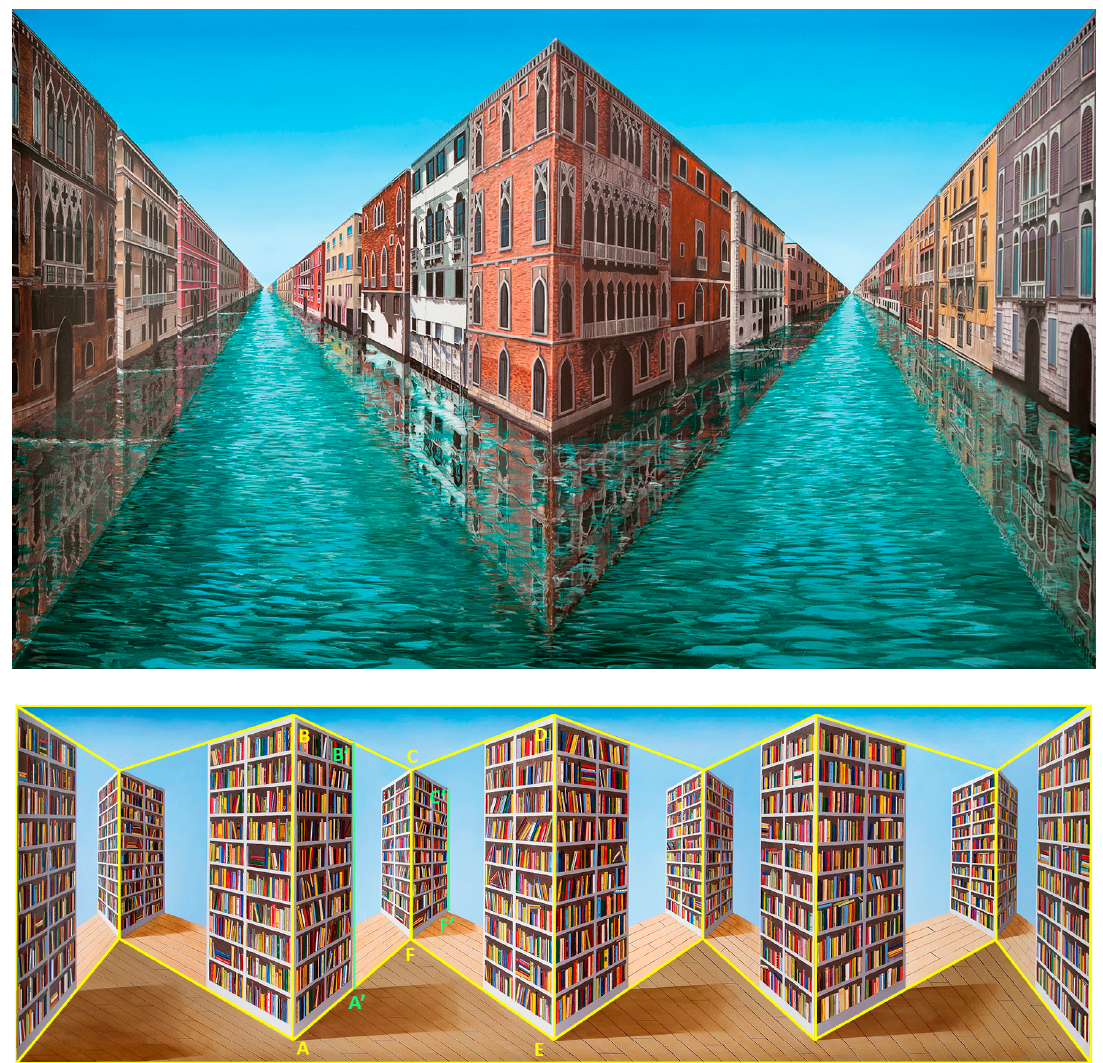
Figure 5. Top panel: “Double Infinity” (2013). Bottom panel: “Reverspective versus Perspective” (2007). See text for details.